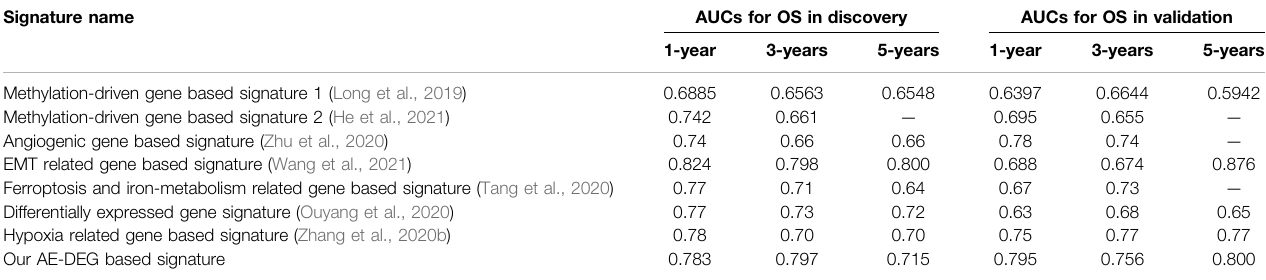
TABLE 4 | Comparison of the predictive performance of our AE-DEG-based signature with seven previously established prognostic signatures in